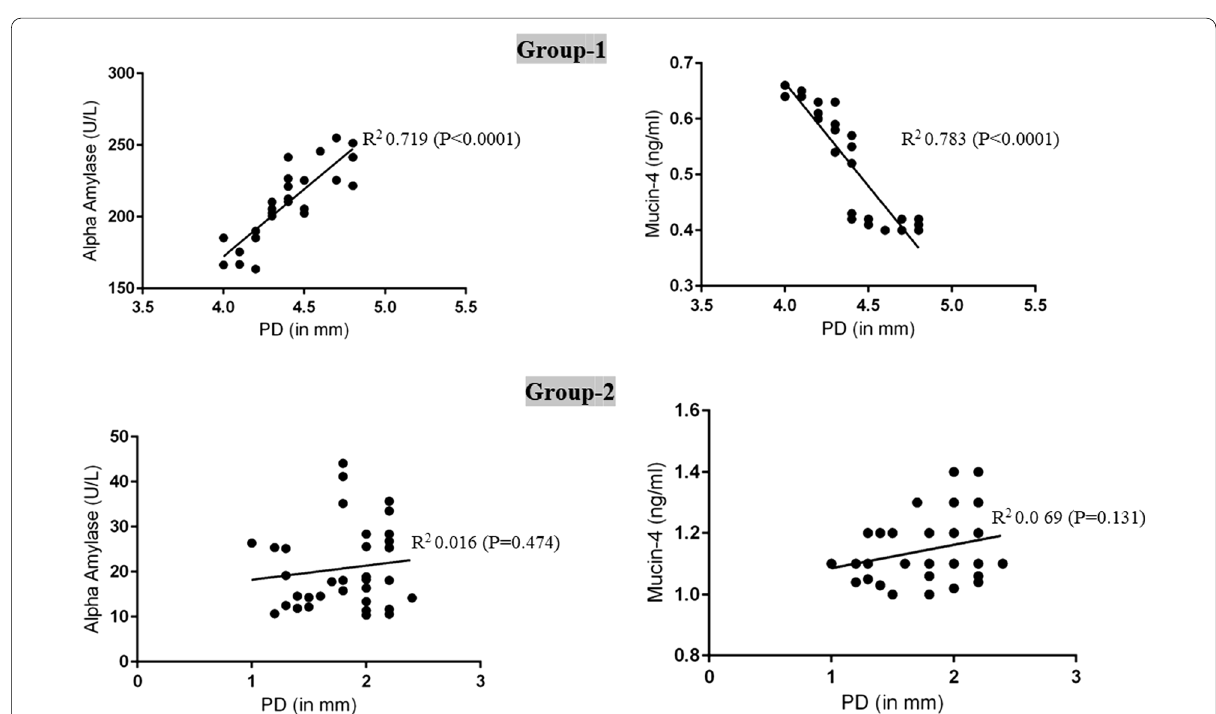
Fig. 1 Logistic regression analysis for the correlation between whole salivary alpha amylase and mucin‑4 levels and peri‑implant probing depth in groups 1 and 2 at